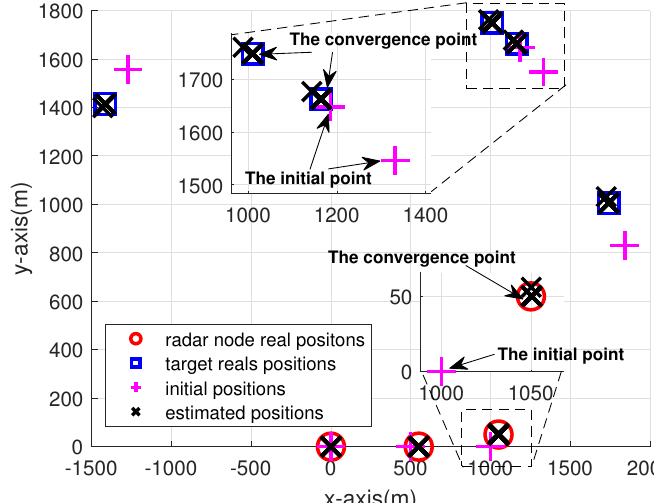
Figure 8. Deployment of radar nodes and targets.